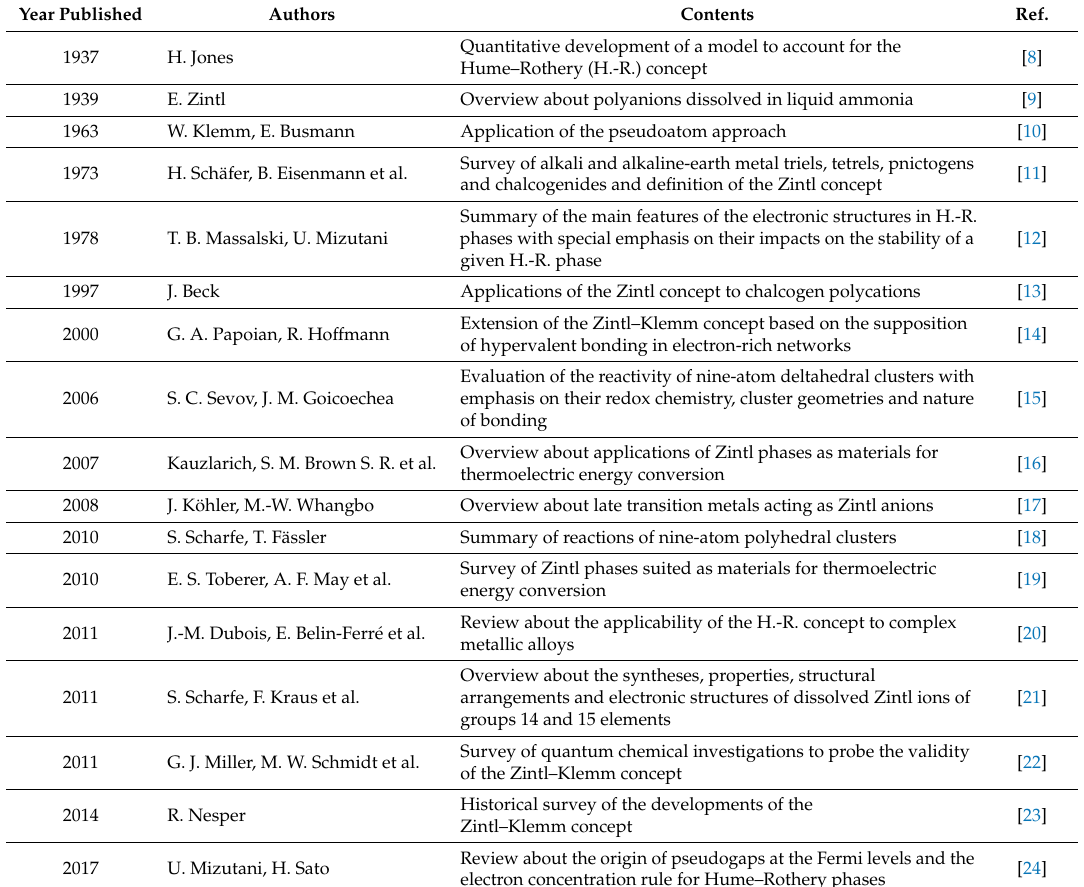
Table 1. Overview about selected reviews regarding compounds to which the Zintl–Klemm or the Hume–Rothery concept can be